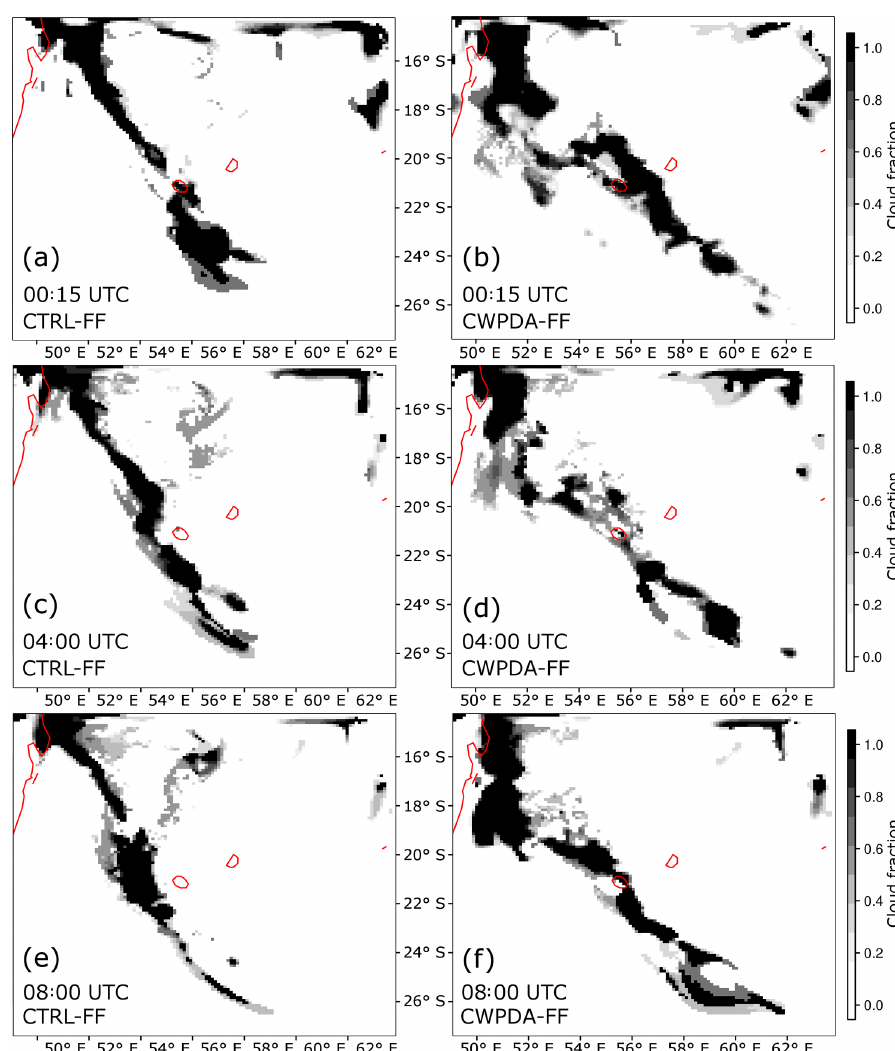
Figure 7. WRF forecasts of cloud fraction at 300hPa from the CTRL-FF (a, c, e) and CWPDA-FF (b, d, f) experiments on 12 January 2018 at 00:15UTC (a, b) , 04:00UTC (c, d) , and 08:00UTC (e, f) . The initial conditions originate from the experiments CTRL and CWPDA, respectively. Coastal lines are shown in